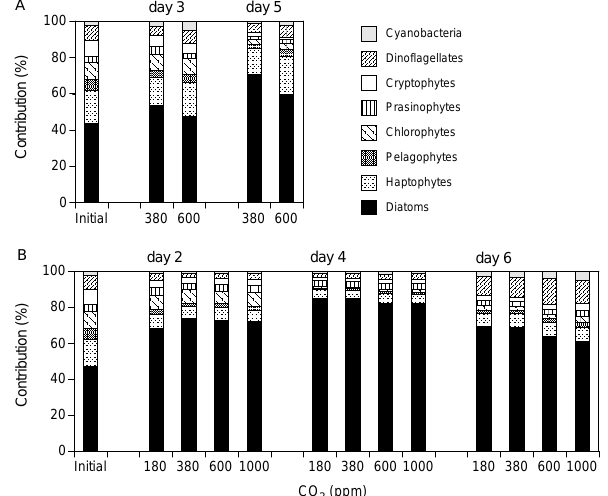
Figure 2. Mean contributions of each phytoplankton group to total Chl a biomass estimated by CHEMTAX in the (a) control bottles at 380 and 600ppm CO 2 , and (b) Fe-added bottles at 180, 380, 600, and 1000ppm CO 2 ( n = 1 or 3).